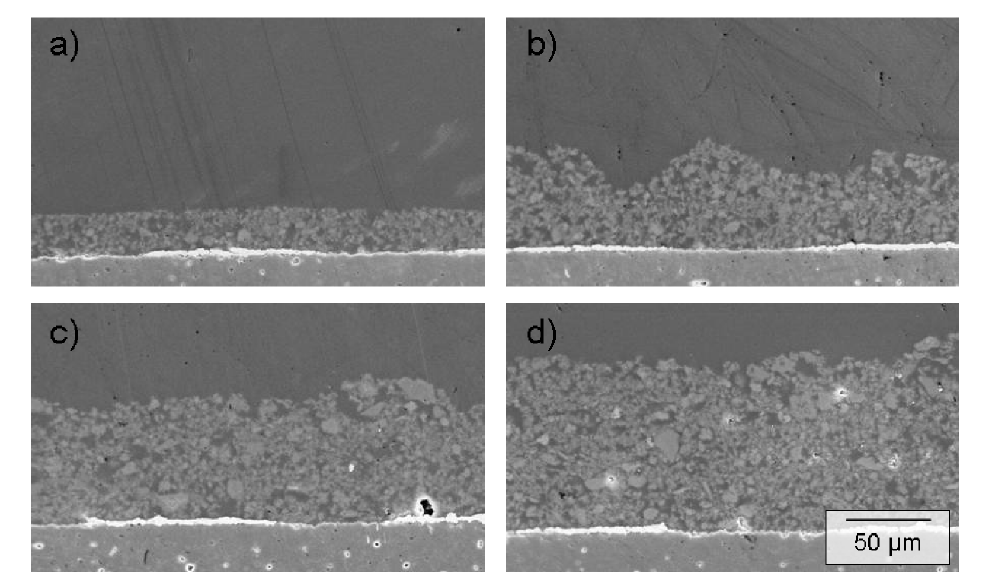
Figure 3. SEM micrographs of the cross section of a sensor with (a) one (~25 µm); (b) two (~50 µm); (c) three (~75 µm); and (d) four (~100 µm) screen-printed zeolite layers on gold interdigital electrodes on alumina